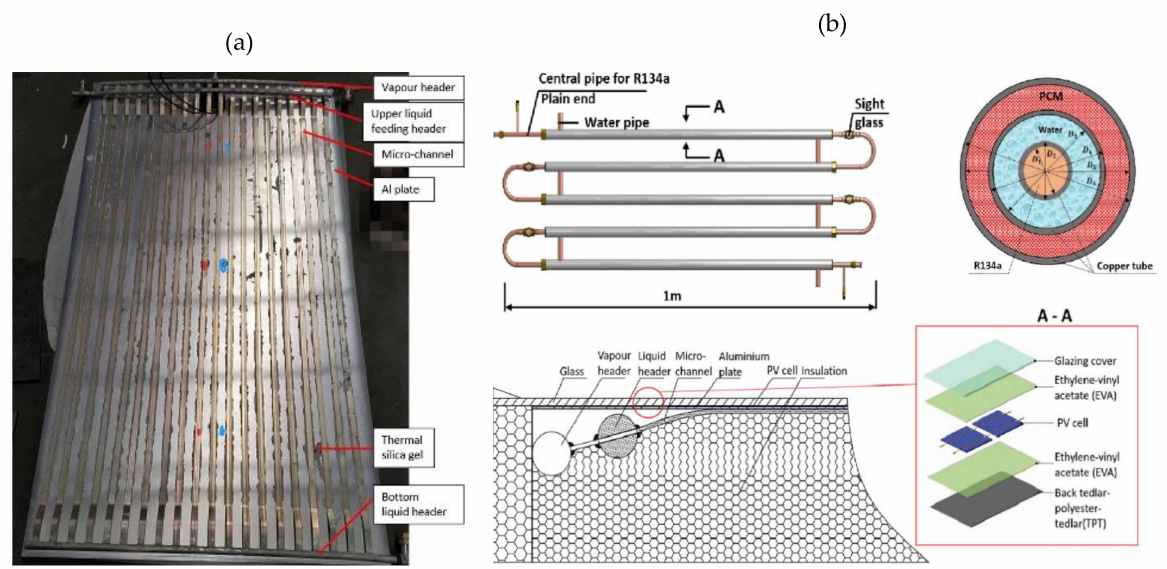
Figure 28. ( a ) Microchannel evaporator; ( b ) structure of triple-pipe heat exchanger and microchannel module (reprinted from [133], with permission from publisher).